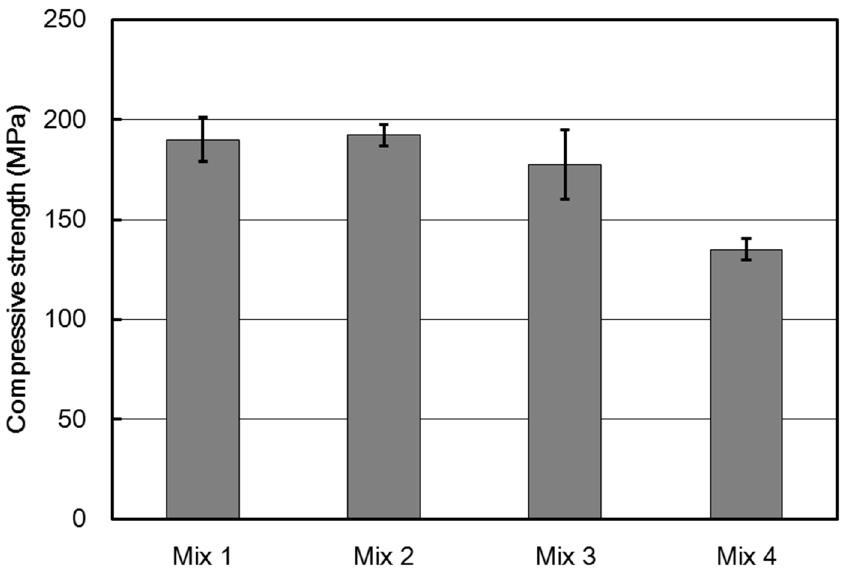
Figure 7. Comparison of compressive strengths with different mixes.